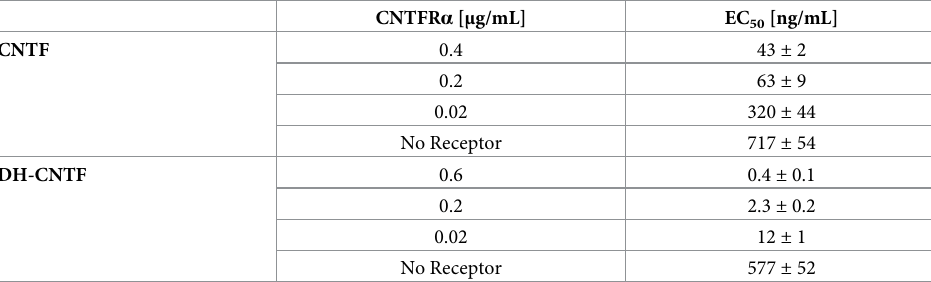
Table 1. Potency (EC 50 , mean ± S.E.) of CNTF and DH-CNTF in the absence and in the presence of different amounts of soluble CNTFR α